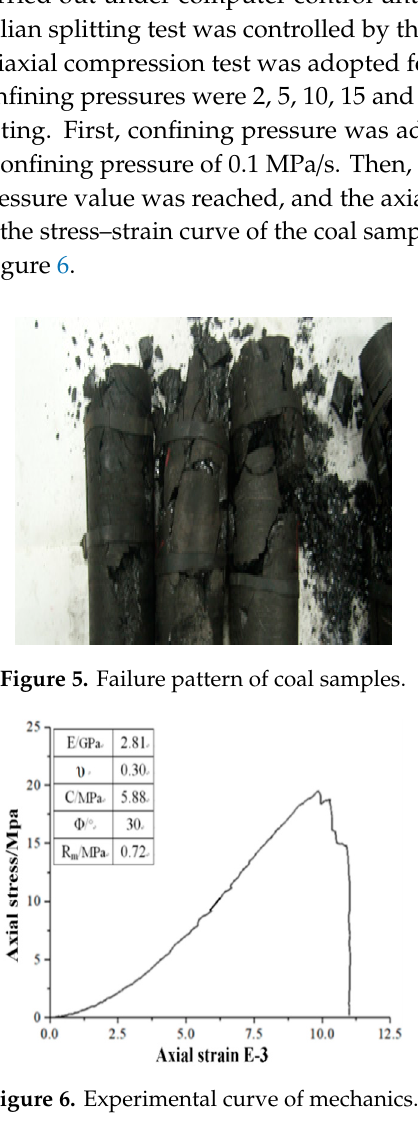
Figure 6. Experimental curve of